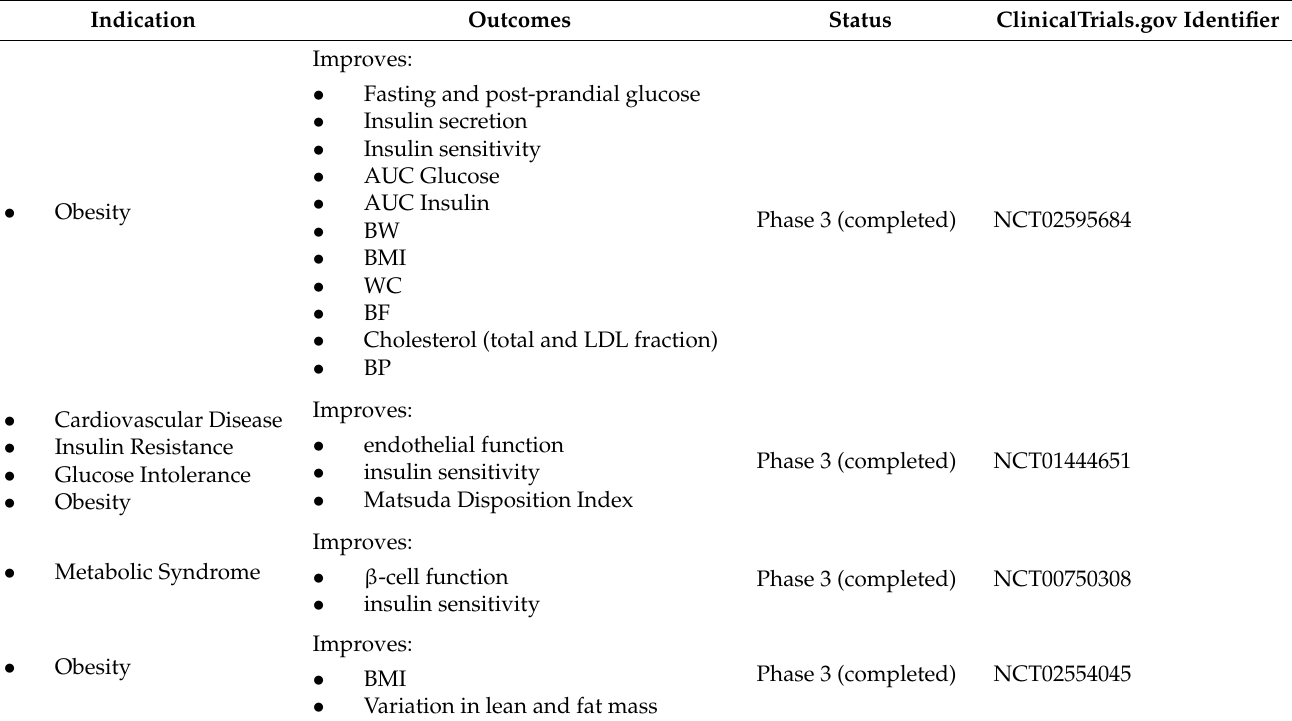
Table 1. List of studies on PDE5 inhibitor tadalafil, body mass and insulin resistance/sensitivity at www.clinicaltrials.gov (accessed on 30 March 2022).